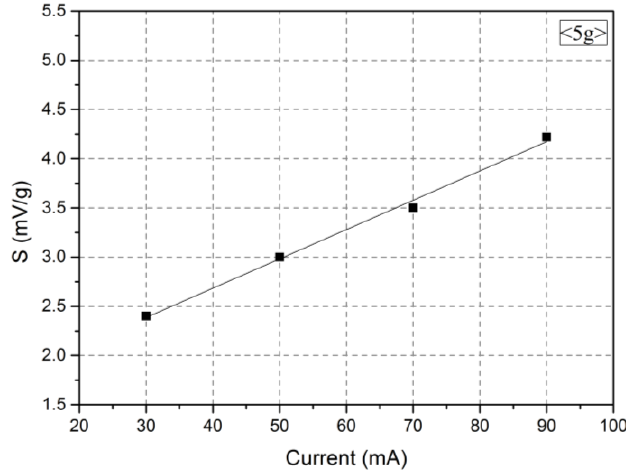
Figure 5. Sensitivity variation according to the current of the micro heater.